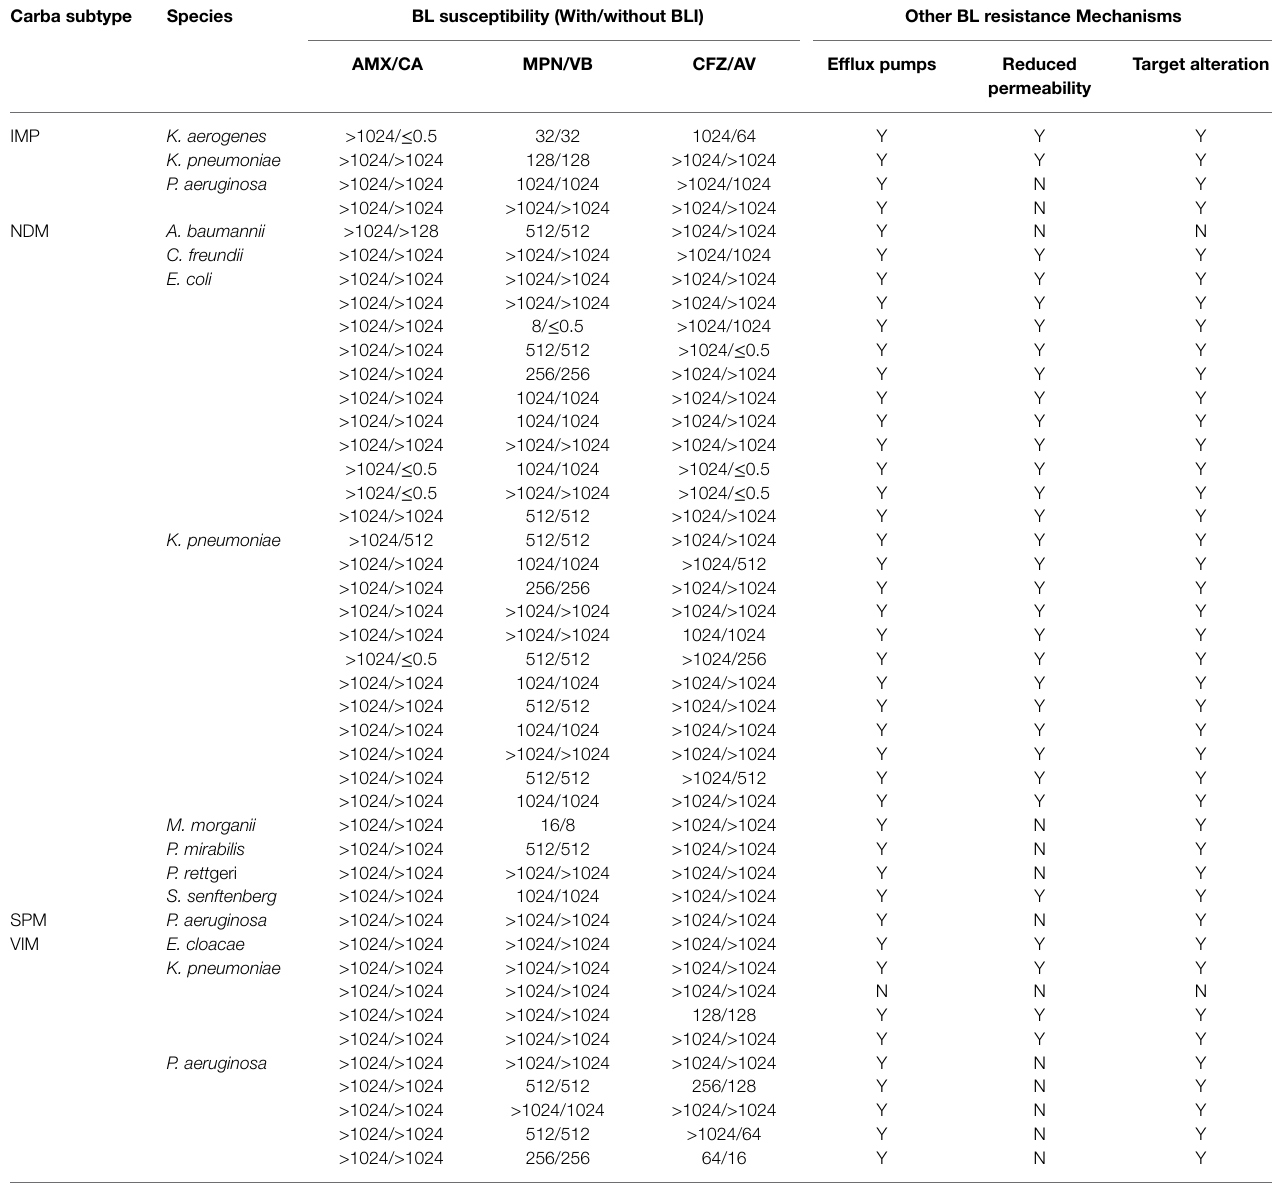
TABLE 2 | Class B carbapenemase-producing isolates included in this study. Carba